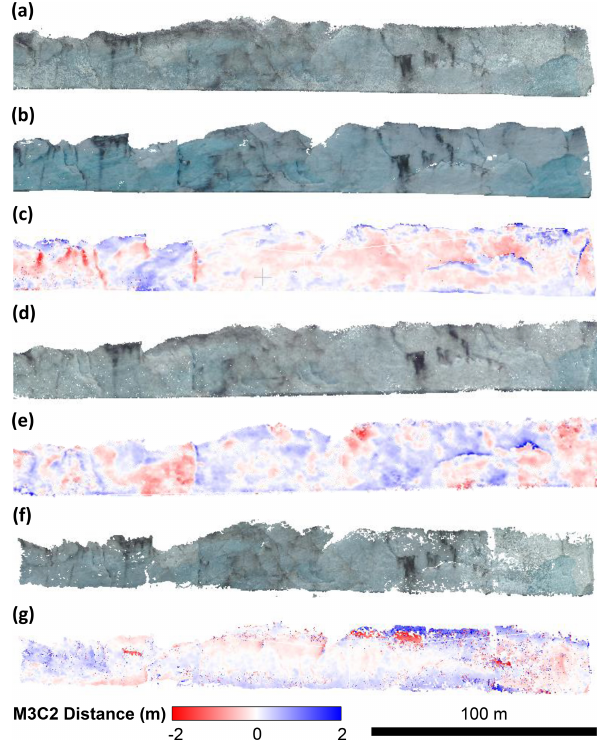
Figure 6. Exploring the limits of the Raspberry Pi sensor in compar- ison to UAV. (a–c) Sub-section B as generated by (a) Raspberry Pi), (b) UAV, and (c) the corresponding M3C2 comparison. (d) Point cloud generated by Raspberry Pi when positioned from the Fjall- sárlón shoreline, at a distance of 1.2–1.5km, and (e) corresponding M3C2 comparison with UAV. (f) Point cloud generated by Rasp- berry Pi from 10 images, and (g) corresponding M3C2 comparison with